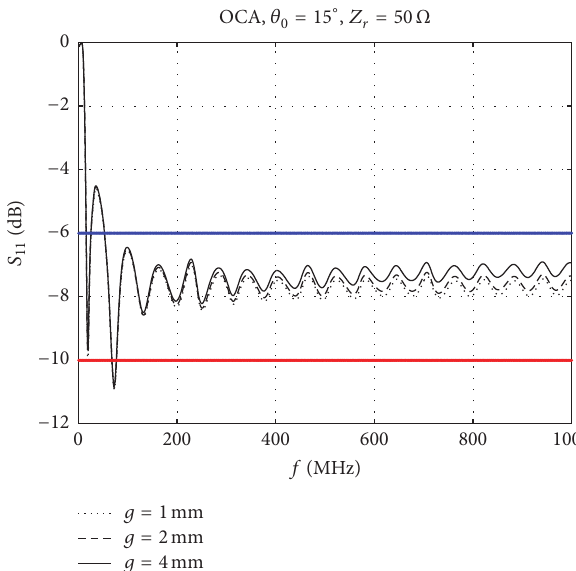
Figure 22: 𝑍 of the OCA for 3 different gap lengths and 𝜃 0 = 45 ∘ in ( 𝑅 : curves above, 𝑋 : curves below). in in